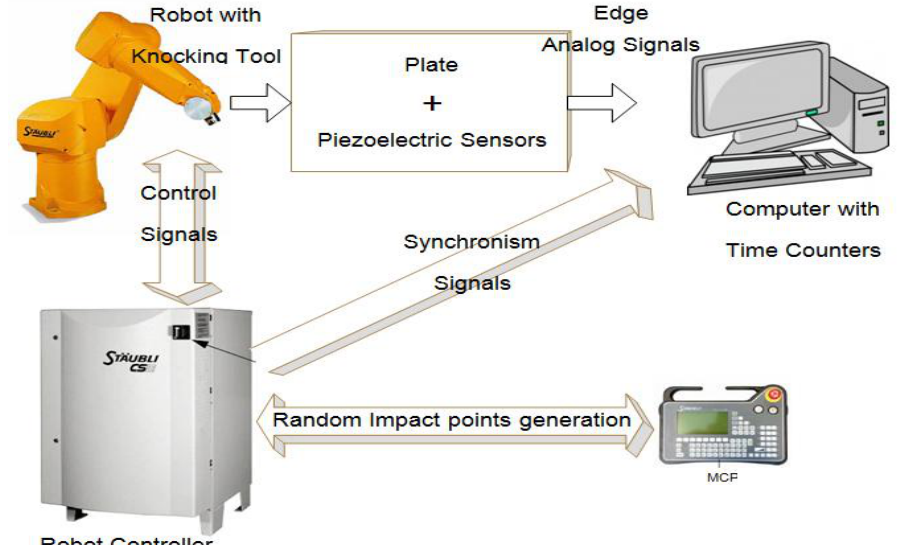
Figure 10. Experimental setup schematic